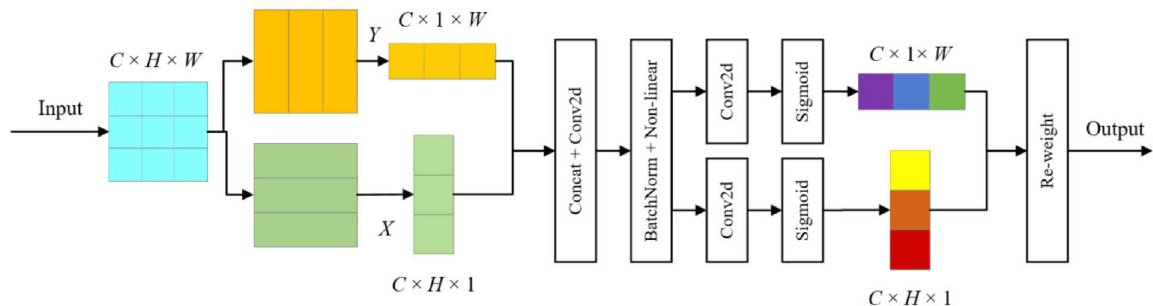
Figure 4. The construction of the CA module. C Indicates channel; H Indicates height; W Indicates